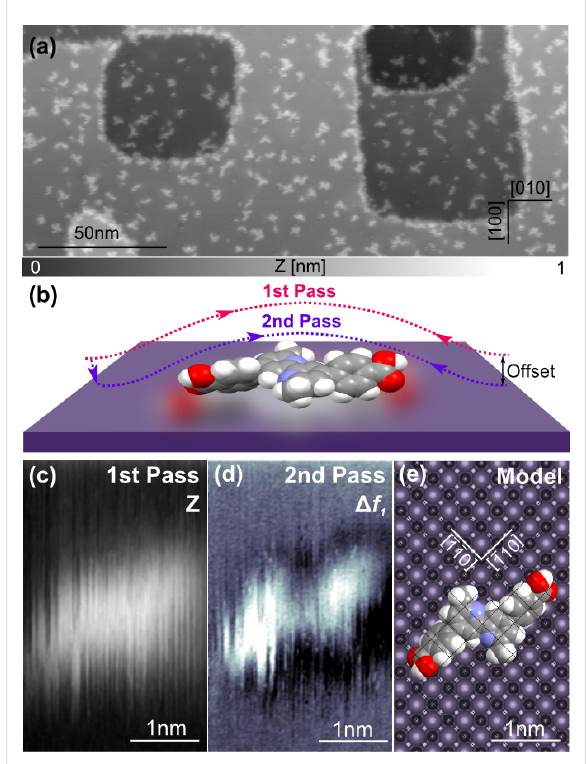
Figure 3: Single DCPDMbpy molecules on NiO(001). (a) Topographic image of NiO(001) covered with DCPDMbpy after low-coverage expo- sure (scan parameters: = 4 nm, Δ f 1 = − 3 Hz). (b) Sketch of the multipass technique. (c) Topographic image of a single DCPDMbpy molecule adsorbed an a terrace acquired in the first scanning pass (scan parameters: = 4 nm, Δ f 1 = − 2.5 Hz). (d) Frequency shift image recorded in the second scanning pass with an offset of − 350 pm showing that DCPDMbpy on the surface is in the trans-conformation. (e) Model of DCPDMbpy in a trans-conformation on the NiO(001) sur-